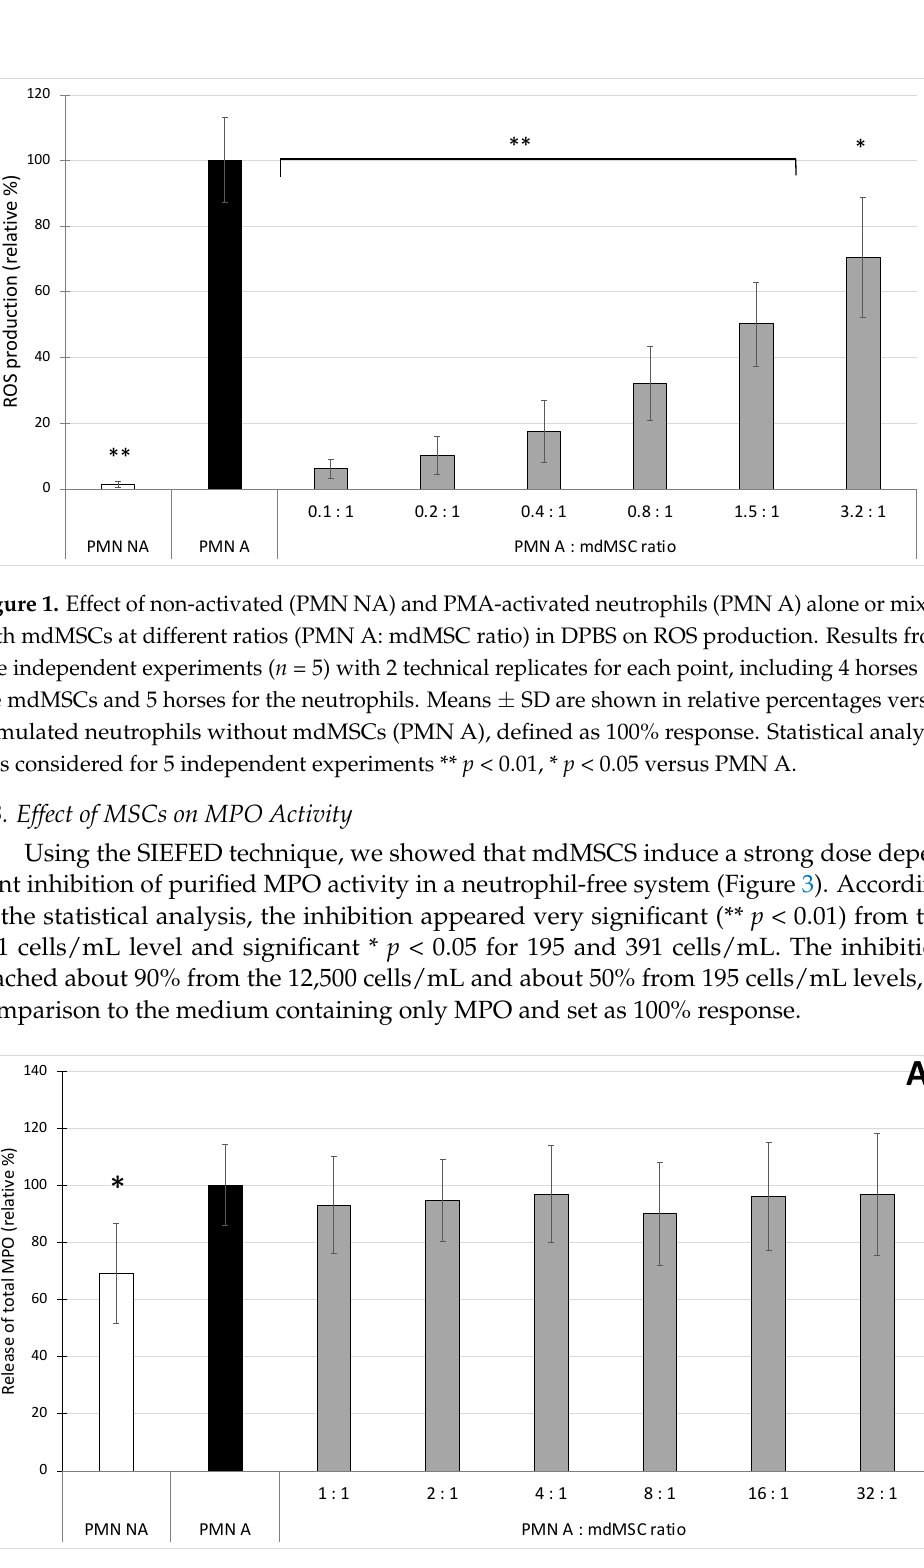
Figure 2. Effect of non-activated (PMN NA) and CB/fMLP-activated neutrophils (PMN A) alone or mixed with mdMSCs at different ratios (PMN A:mdMSC ratio) in DPBS on the degranulation of total ( A ) and active MPO ( B ). Results from five independent experiments ( n = 5) with 2 technical replicates for each point, including 4 horses for mdMSCs, 5 horses for neutrophils. Means ± SD are shown in relative percentages versus stimulated neutrophils alone defined as 100% response (PMN A). Statistical analysis was considered for 5 independent experiments ** p < 0.01, * p < 0.05 vs. PMN A. 3.3. Effect of MSCs on MPO Activity Using the SIEFED technique, we showed that mdMSCS induce a strong dose depend- ent inhibition of purified MPO activity in a neutrophil-free system (Figure 3). According to the statistical analysis, the inhibition appeared very significant (** p < 0.01) from the 781 cells/mL level and significant * p < 0.05 for 195 and 391 cells/mL. The inhibition reached about 90% from the 12,500 cells/mL and about 50% from 195 cells/mL levels, in compari- son to the medium containing only MPO and set as 100% response. 0